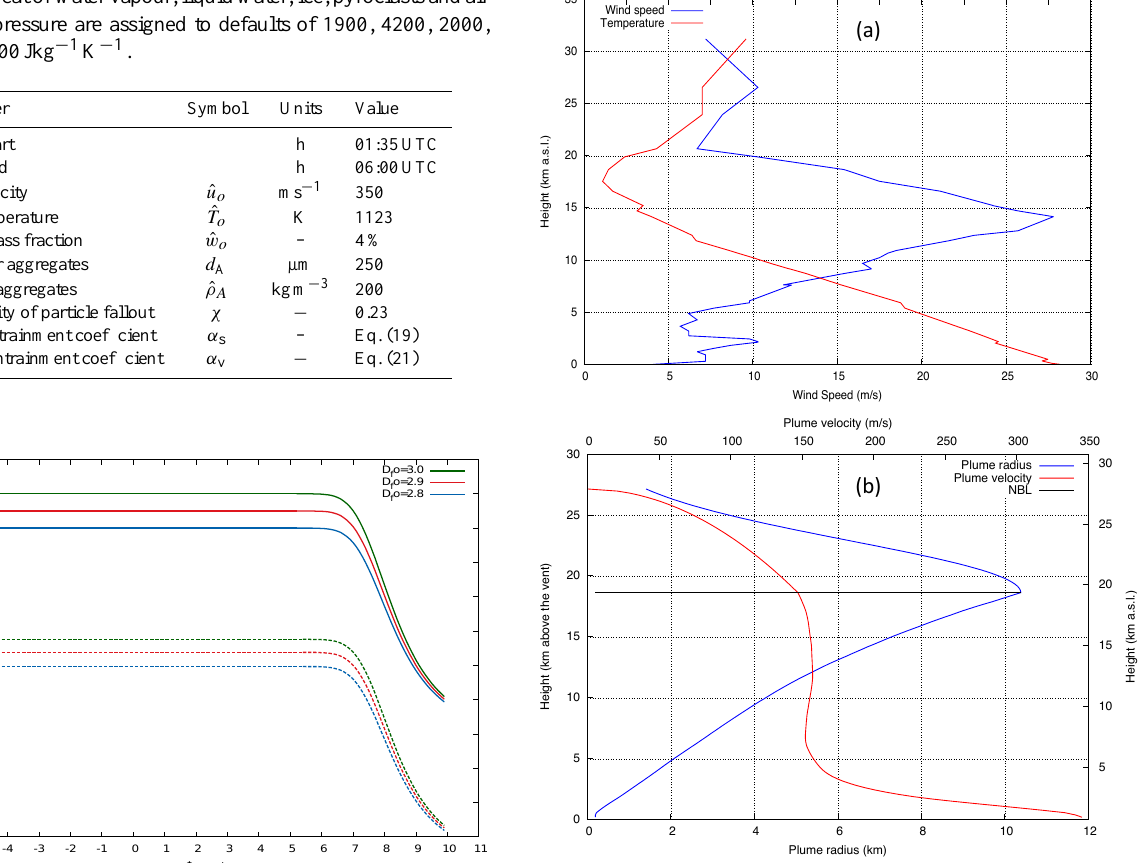
Figure 4. Dependency of fractal exponent D f (continuous lines) and fractal pre-factor k f (dashed lines) on particle size expressed in (cid:56) units according to Eq. (32) and (33) for different values of D fo . Note the progressive decay in D f starting at (cid:56) = 7 ( d ≈ 10µm) and leading to values of D f = 1 . 6 for (cid:56) = 9 ( d ≈ 2µm).